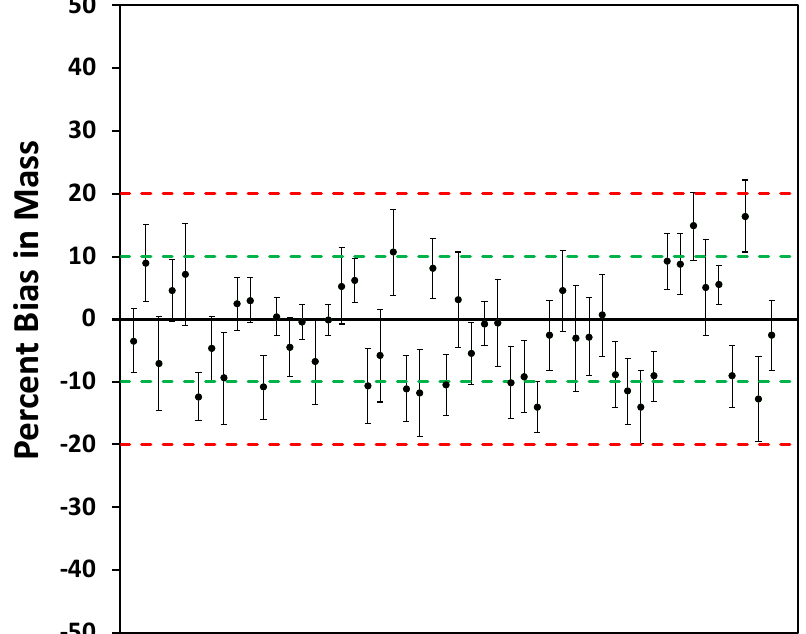
Figure 5. Bias value for the 50 selected PM sensors, based on Method 1, compared to the pDR-1500. The y -axis error bars represent the 90% confidence intervals. The dashed green and red lines represent 10% and 20% bias, respectively.